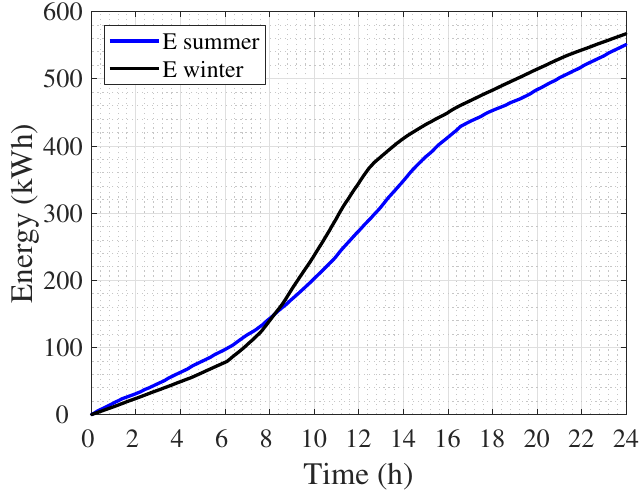
Figure 8. Cumulative energy consumed by the load in summer and winter